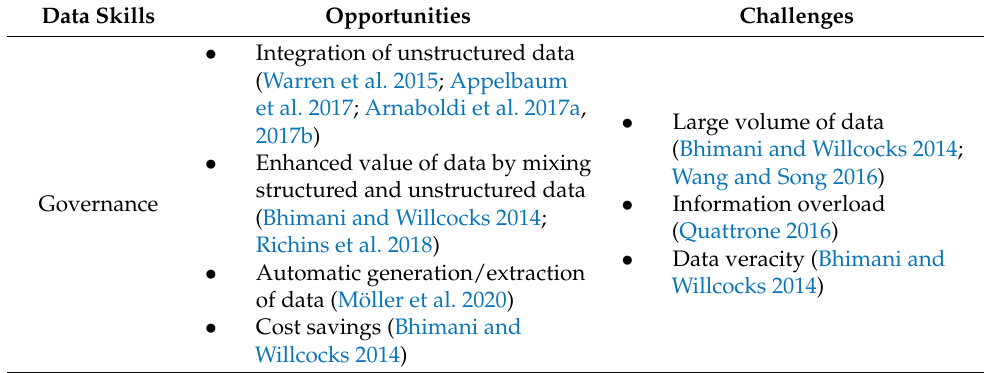
Table 3. Opportunities and challenges regarding the MA’s BA